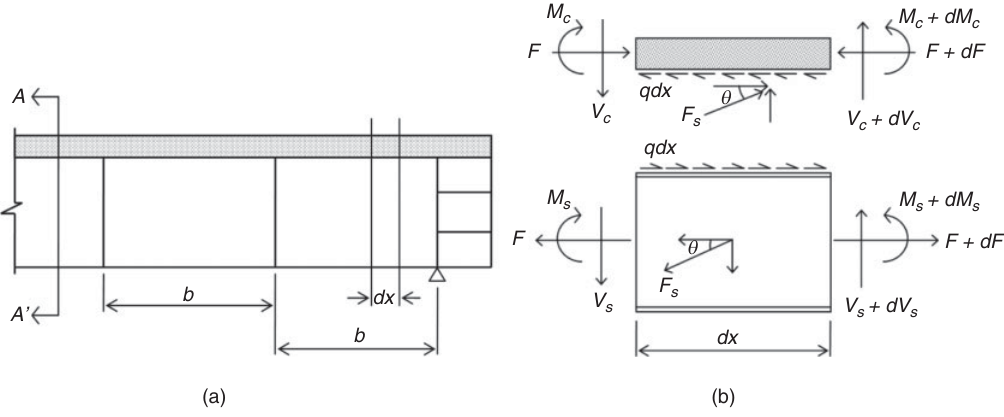
Fig. 1. Calculation model for a typical composite girder